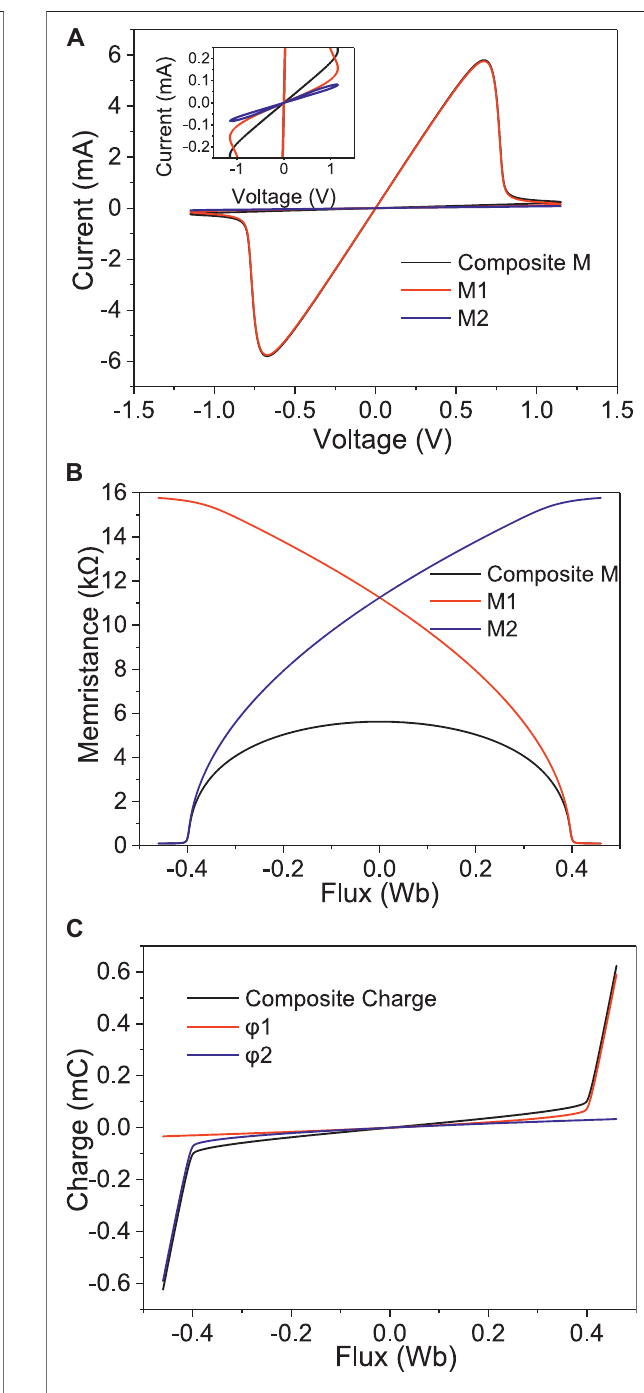
FIGURE14|(A) Current versusvoltage curves, (B) memristance versus fl ux curves, and (C) charge versus fl ux curves of the single memristor and two memristors in parallel with opposite